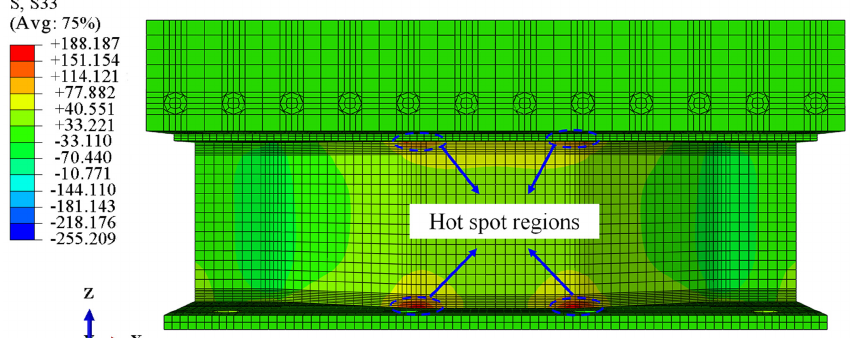
Figure 14. Stress nephogram of the FE model. (Unit: MPa).